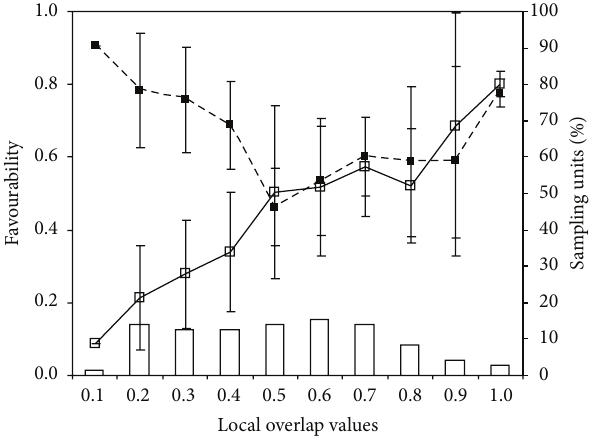
Figure 4: F - Mauremys -Ecogeographical model (solid lines, filled squares) and F - Trachemys -Encroachment model (dashed lines, hollow squares). Favourability is shown on the y -axis (ranging from 0 to 1); fuzzy overlap between the favourabilities for the two species is shown on the x -axis (ranging from 0.1 to 1); columns and sampling unit values represent the percentage of grid cells at each overlap interval.